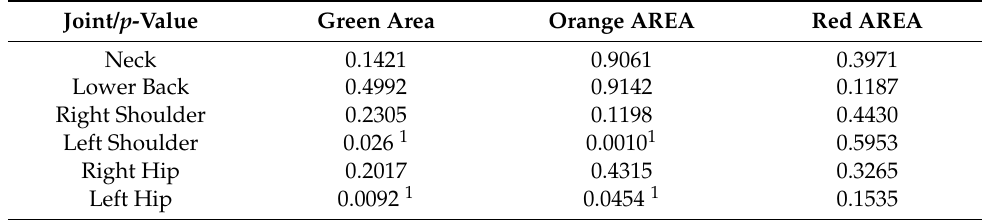
Table 5. Test result–paired t -test ( α = 0.05). Nonparametric Wilcoxon pairwise test for pairwise comparisons with the resulting p -values. The null hypothesis (H 0 : m 1 = m 2 ) was “the medians of both sets are the same” and the alternative hypothesis (H 1 : m 1 (cid:54) = m 2 ) was “the medians of both sets are not the